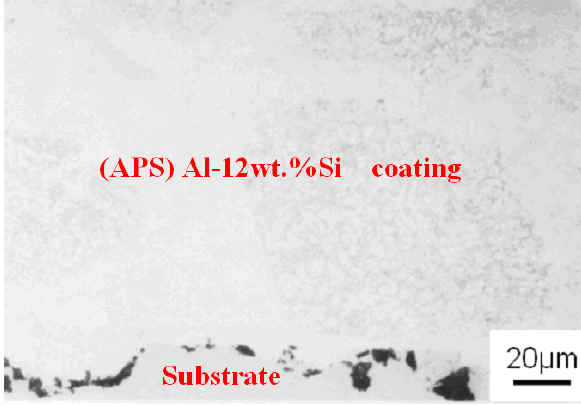
Figure 4: (OM) Al-12Si coating microstructure deposited with pow- der feed rate 45 g/min